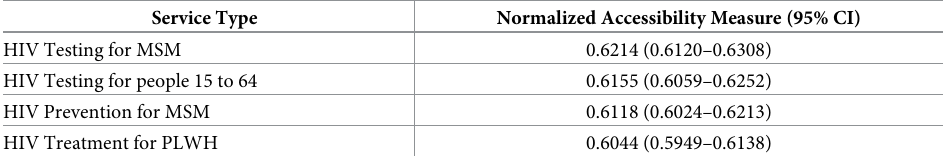
Table 2. Accessibility measure in Chicago. (a) Treatment for PLWH; (b) Prevention for MSM; (c) Testing for MSM and people aged 15 to